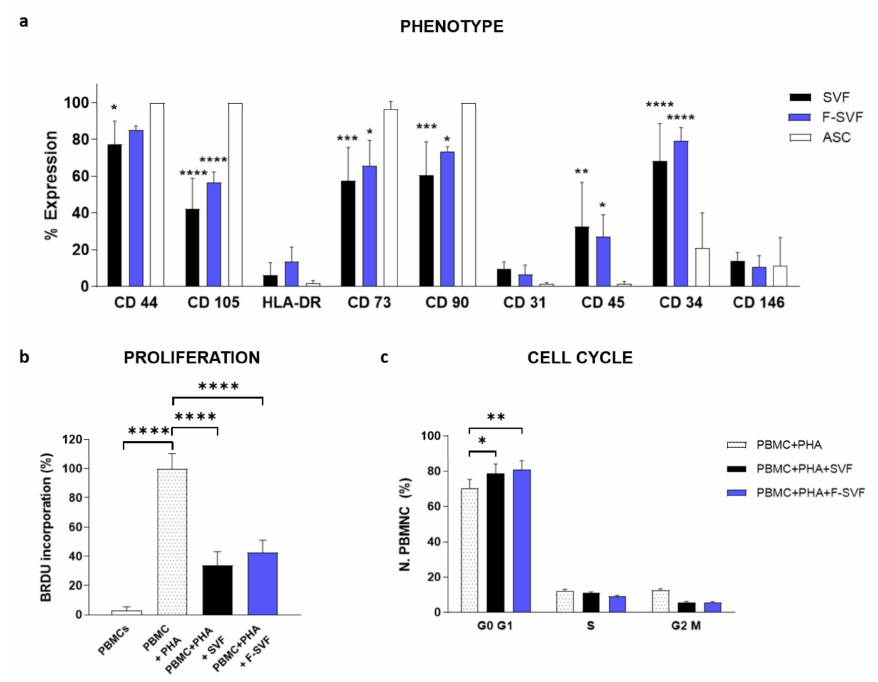
Figure 5. Phenotype characterization of stromal vascular fraction (SVF) and the fraction derived stromal vascular fraction (F-SVF) cells by flow cytometry. Mesenchymal markers were slightly more expressed in the F-SVF, proving an enrichment of the mesenchymal component of the SVF due to the label-free sorting ( a ). SVF and F-SVF cells showed the same immunomodulatory ability to inhibit the proliferation of PHA-stimulated PBMCs by BrdU assay ( b ). Moreover, it was shown that SVF and F-SVF cells arrested stimulated PBMCs in the G0/G1 phase of the cell cycle ( c ). *: p < 0.05; **: p < 0.01; ***: p < 0.001; ****: p <